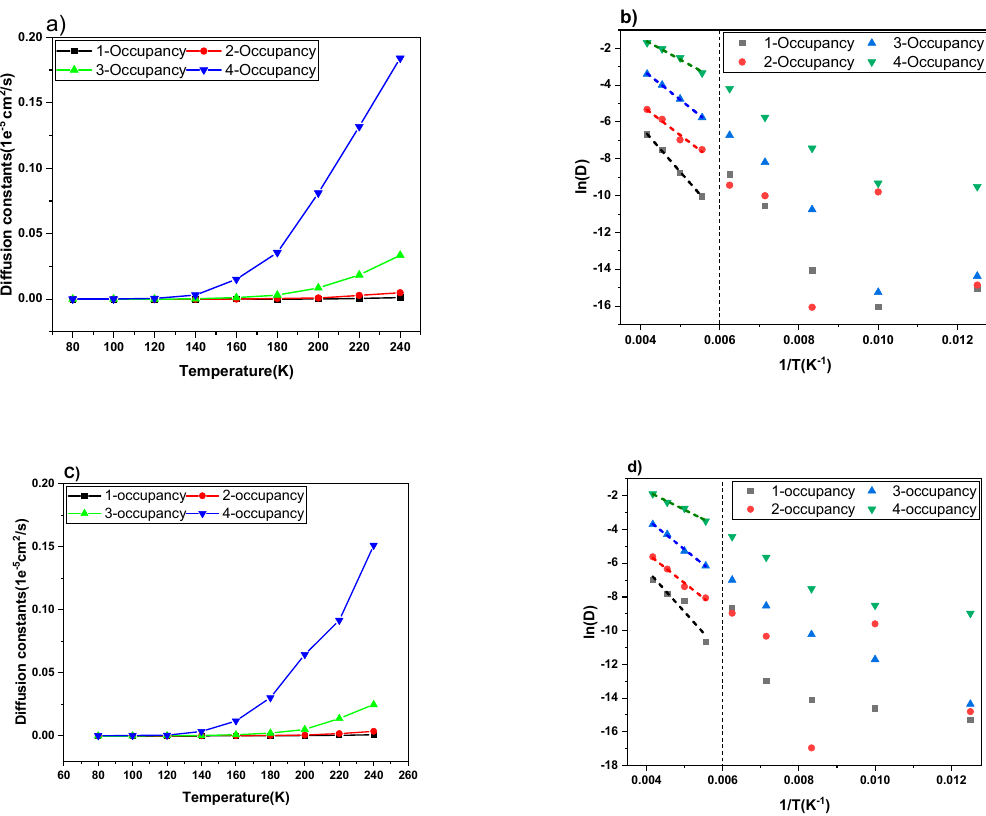
Figure 2. Diffusion coefficient for the different configurations at various temperature. ( a ) H 2 , ( b ) Arrhenius fitting for H 2 ( c ) D 2, and ( d ) Arrhenius fitting for D 2 . The area selected for the Arrhenius fitting is highlighted in yellow. The dashed lines present the fitted line for the Arrhenius equation.